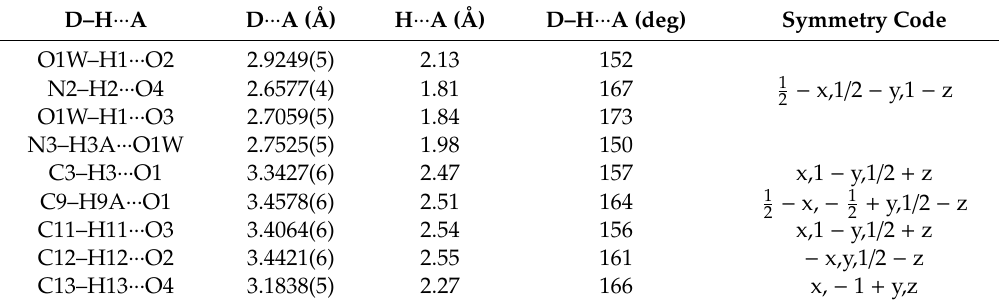
Figure 4. Two different configurations of IM + –NPG − –HYD in the supramolecular assembly: ( a ) A and ( b ) B . Distances of π – π stacking and hydrogen bonds are in angstrom, and the green line depicts the hydrogen bonds. The interfragmentary interaction energy between each IM + , NPG – , and H 2 O moieties is calculated via Hirshfeld charge analysis. Table 3. Hydrogen bonds in IM + –NPG −